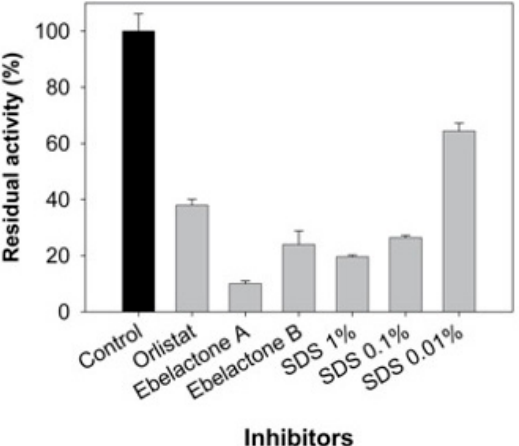
Figure 3. Effect of inhibitors on lipolytic activity in juveniles of common snook C. undecimalis .